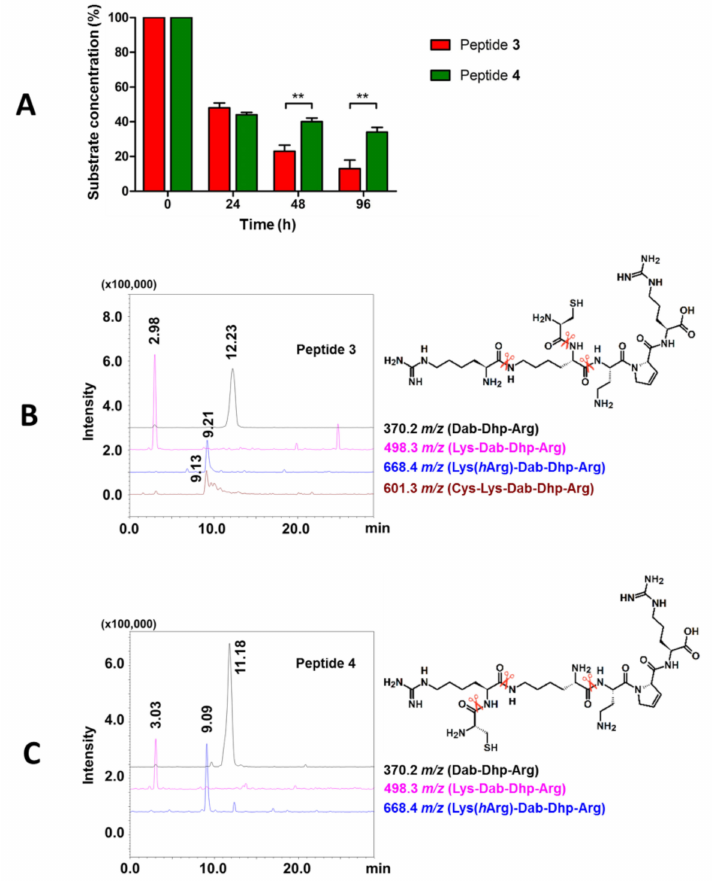
Figure 2. ( A ) Comparison of the in vitro metabolic stability of peptides 3 and 4 . Results are presented as the mean ± SEM of two independent experiments performed in duplicates. Di ff erences between peptides concentrations at various time intervals were analyzed by a two-way ANOVA with Bonferroni’s post-tests (** p < 0.01). Extracted ion chromatograms (XICs) of detected metabolites and potential bonds cleaved by enzymes (scissors represent identified proteases cleavage sites) of ( B ) peptide 3 and ( C ) peptide 4